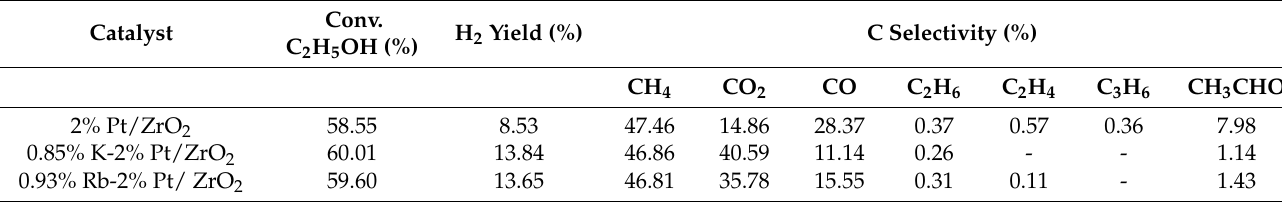
Table 5. ESR catalytic activity for select catalysts at the same C 2 H 5 OH conversion (300 ◦ C, 1 atm, feed: C 2 H 5 OH 2.98% H 2 O 26.14% N 2 70.88%) for selectivity comparison. Catalyst